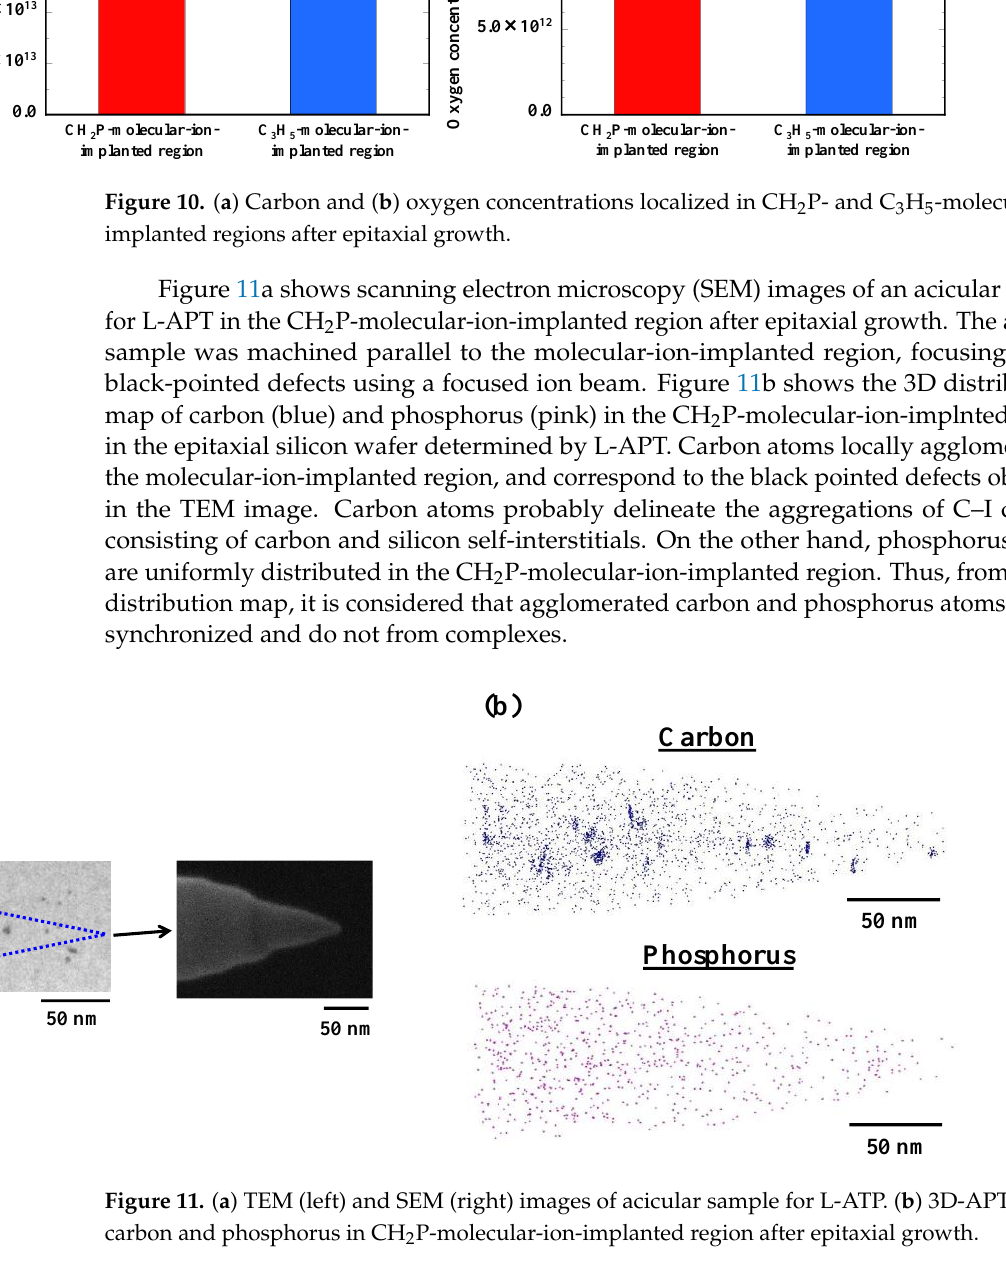
Figure 9. SIMS depth profiles of concentration of ( a ) CH 2 P- and ( b ) C 3 H 5 -molecular-ion-implanted regions after epitaxial growth.